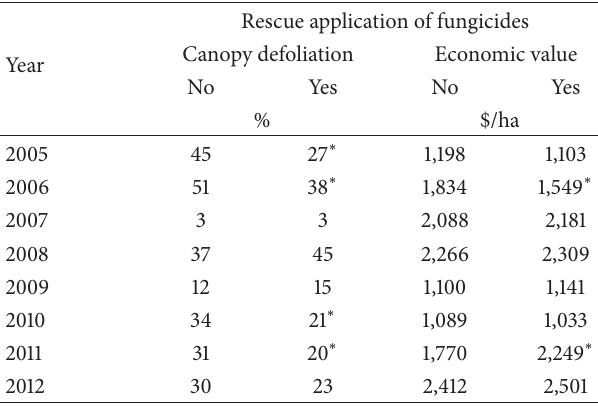
Table 12: Canopy defoliation and economic return following late- season rescue application of fungicides for each